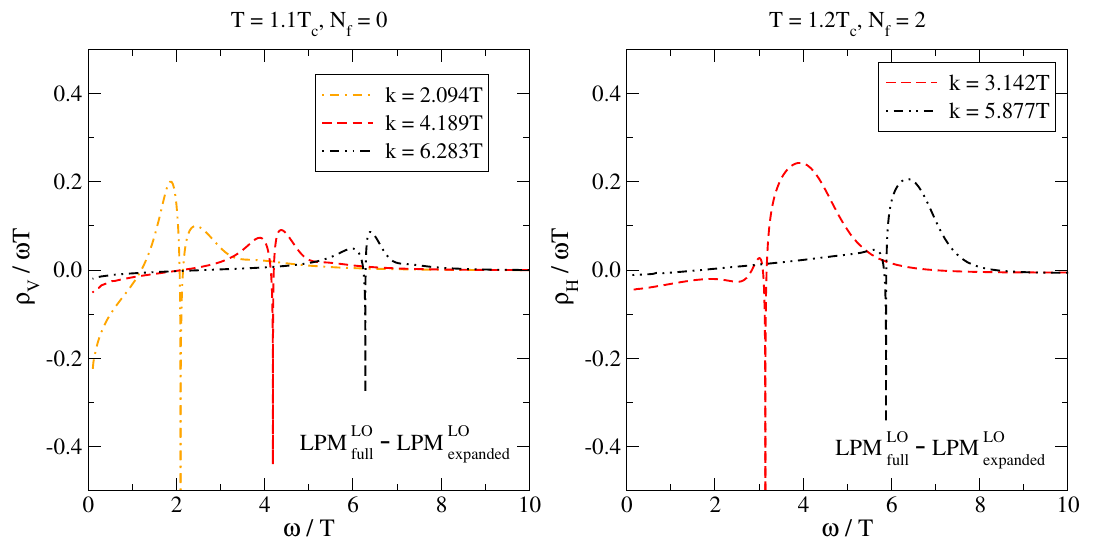
Figure 1 . Left: the modi(cid:12)cation of (cid:26) (cf. eq. (2.3)) by LPM-resummation (cf. section 3.2), for V (cid:22) (cid:22) = (cid:22) (cid:22) . The re-expanded version of the LPM result (cf. section 3.3) has been subtracted in order opt to avoid double-counting once the result is combined with the full unresummed 2-loop expression, cf. eq. (4.1). The logarithmic singularity cancels in this combination. Right: the same for (cid:26) eqs. (2.3),